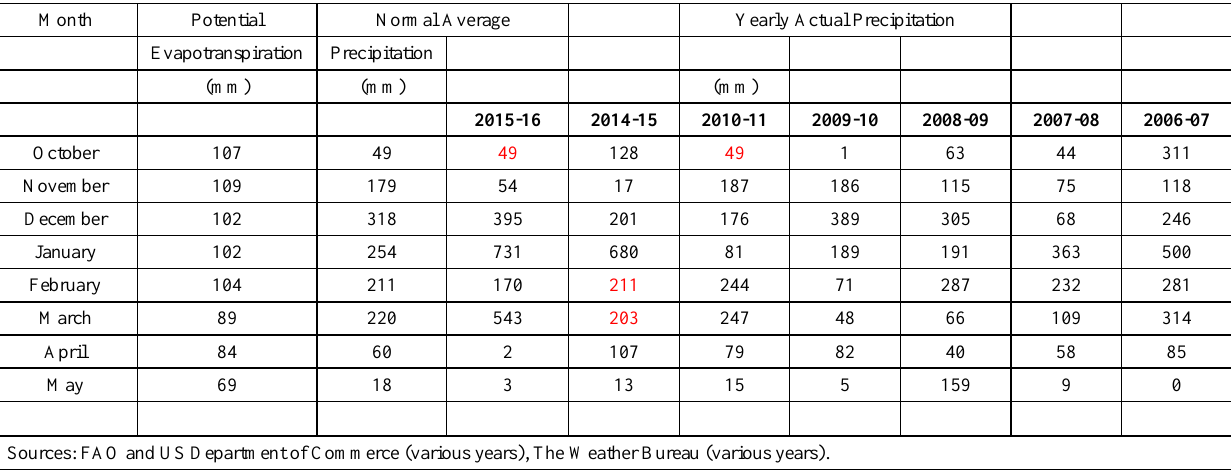
Table 3. Potential Evapotranspiration and Precipitation Near Antananarivo (in Central High Plains